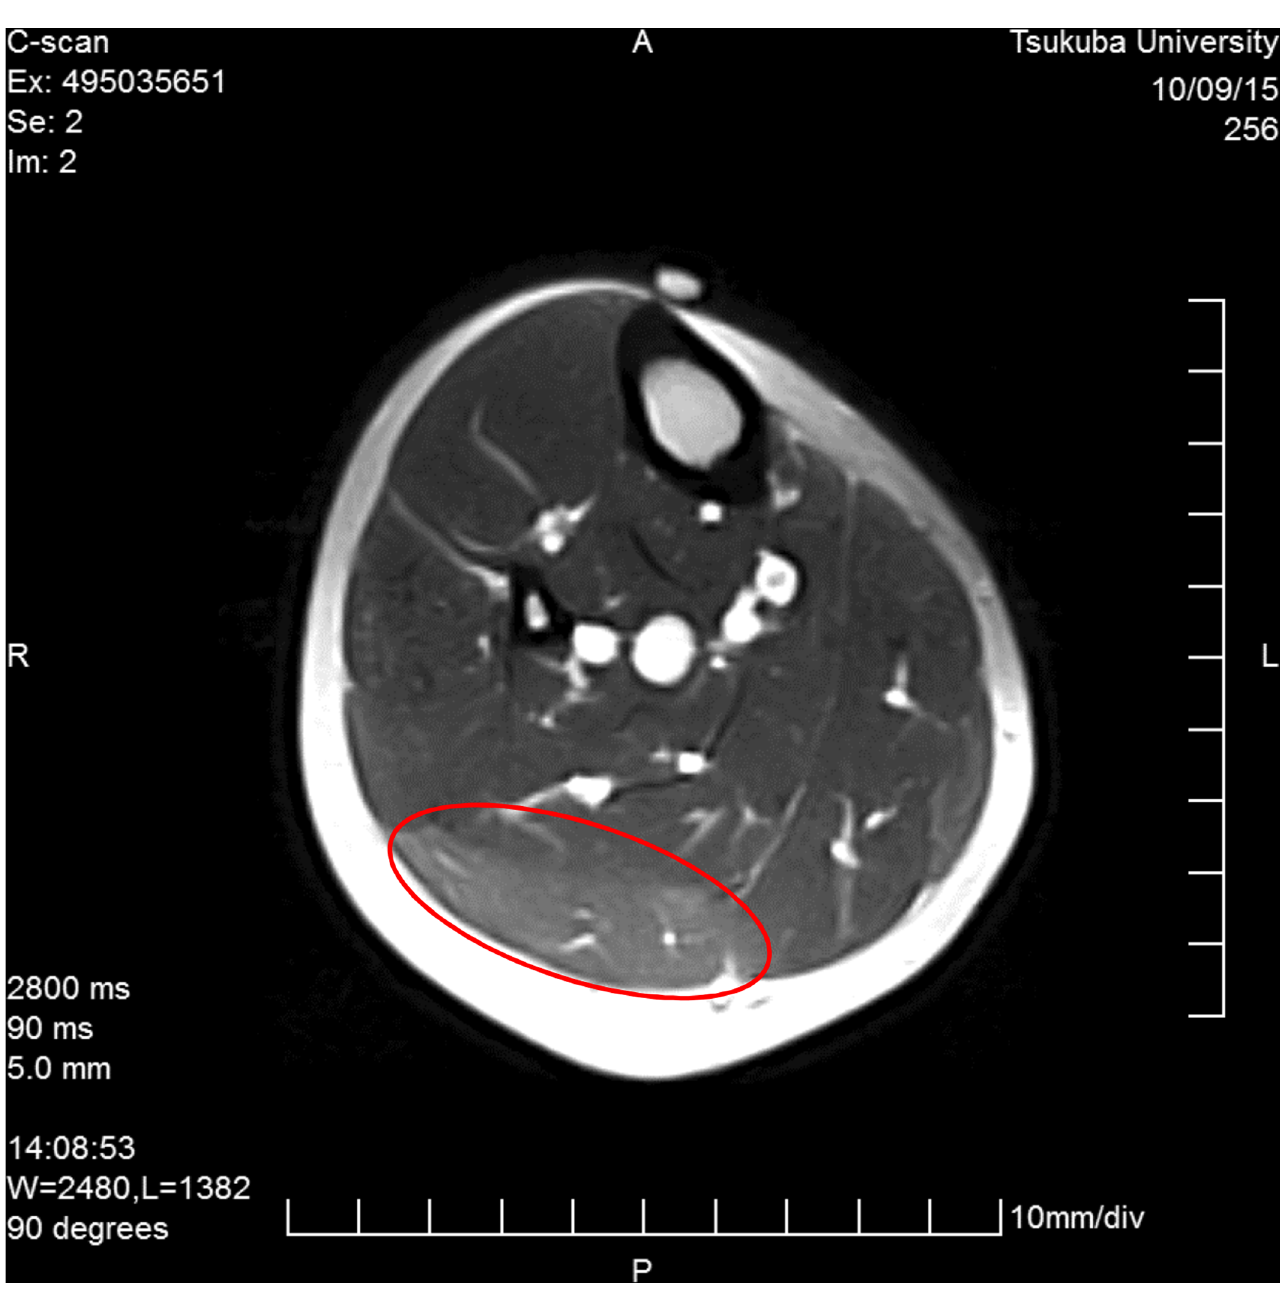
Fig 2. T2 signal and lateral cross-section area of the lateral gastrocnemius. https://doi.org/10.1371/journal.pone.0191022.g002 (Fig 3). Additional parameters used in the analysis were the sway area (mean circle) (cm 2 ), the total locus length of the line tracing COP (cm), the total movement unit length, or the locus length per second (cm/sec), and the locus length per unit area (cm/cm 2 ). Agility was assessed using a side-step exercise, approved by the Japanese Ministry of Educa- tion Science and Technology (MEXT) as a new physical fitness test for people aged 20 to 64 [25]. In this exercise, 3 tape bands are stuck on a flat floor at 1-meter intervals. From a central starting position, the participants have 20 seconds in which to step, as many times as they can,